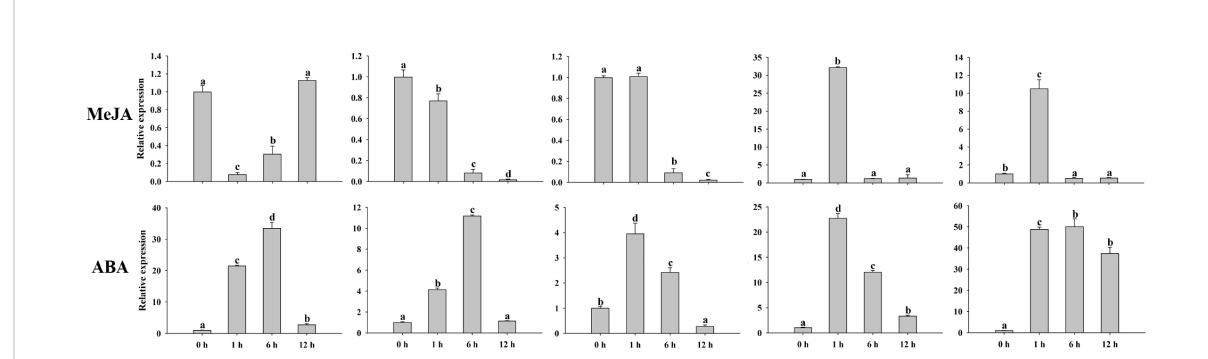
FIGURE 10 Analysis of the relative expression levels of peanut AhMADS genes by qRT-PCR. The expression pro fi les of fi ve peanut AhMADS genes (AhMADS9, AhMADS21, AhMADS34, AhMADS50, and AhMADS64) under two hormone treatments (MeJA and ABA) were validated. The data are presented as the mean ± SD (n = 3), and the values differed signi fi cantly at p < 0.05. Different letters indicate signi fi cant